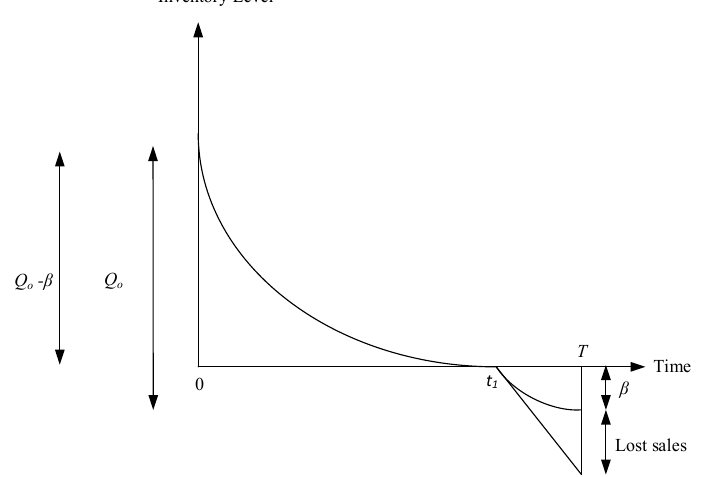
Figure 1. Proposed problem and graph of inventory level against time ([5]).